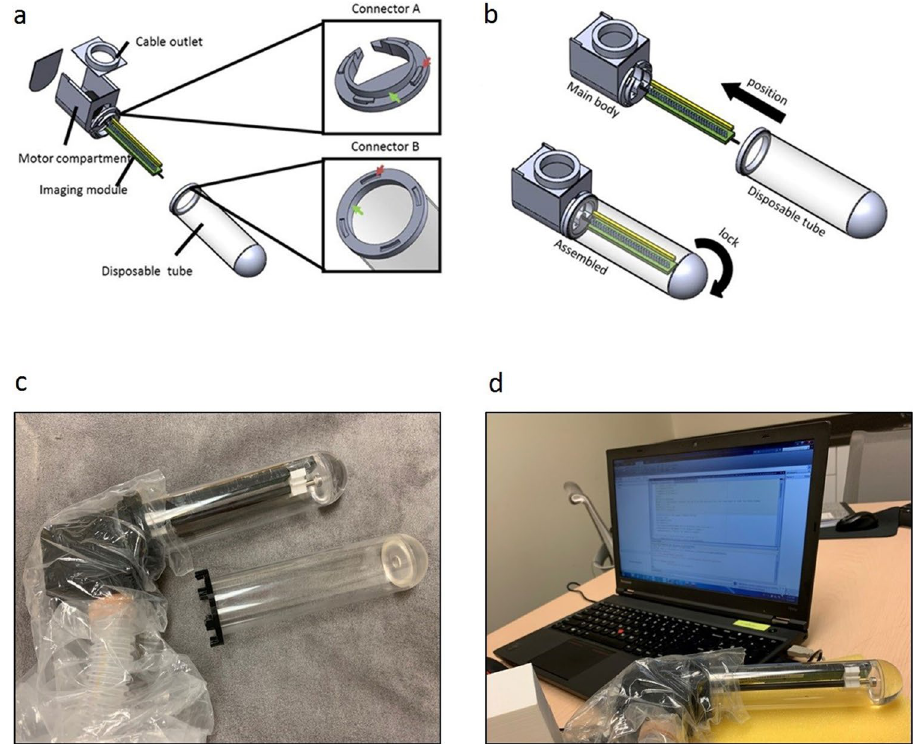
Figure 1. The patient centered re-design of the imaging device. ( a ) The main body consists of the motor compartment and the imaging module. The disposable medical-grade clear polycarbonate tube is mounted and secured to the main body by the use of two built-in connectors. Connector A on the main body and Connector B on the tube are as shown, respectively. ( b ) The tube mounting process for the new AnCam requires insertion of the imaging module into the transparent tube, turning the tube and the main body to engage Connectors A and B. The patient-facing tube is single use and disposable. The non-patient facing main body and tubing are covered with a single use plastic disposable sheath. ( c , d ) Photographs of the scanning endoscope system used in the clinical